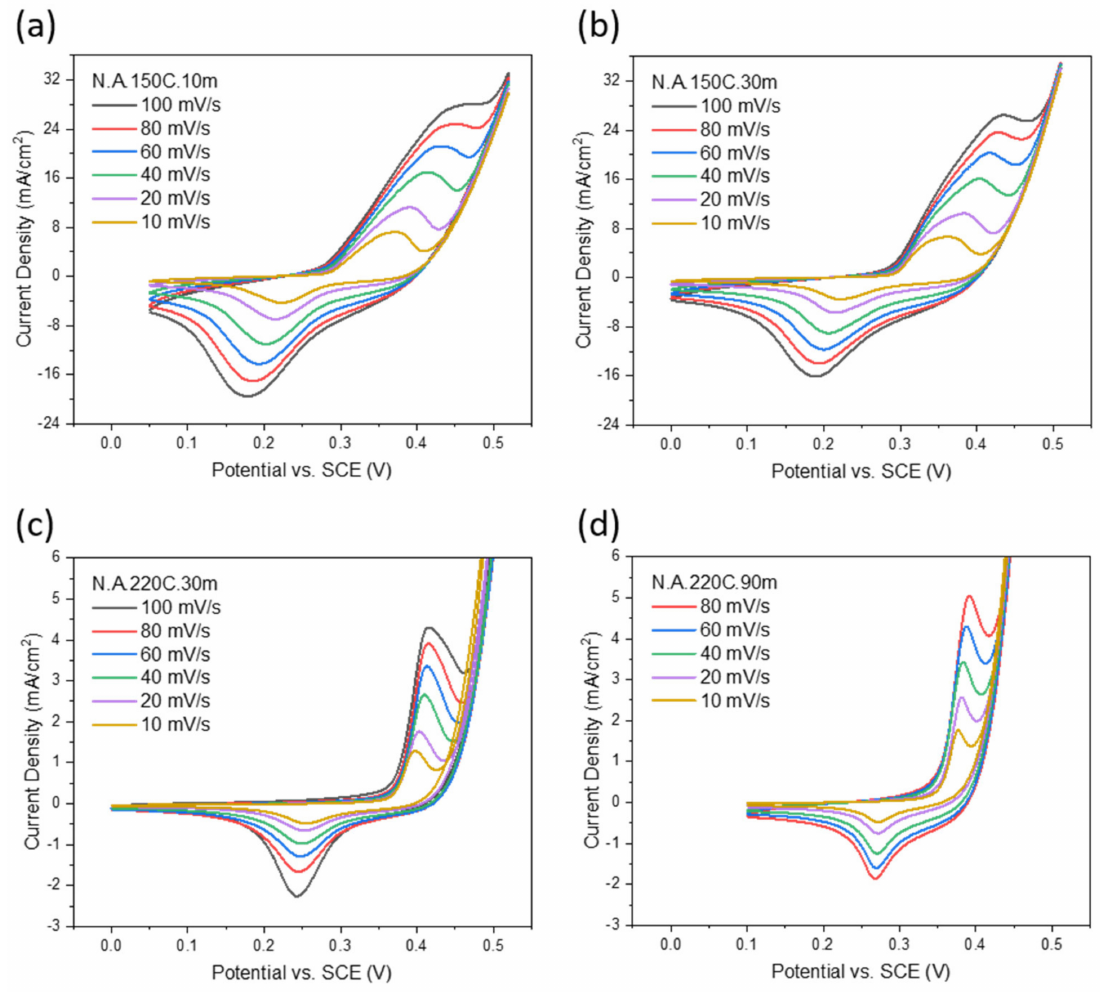
Figure 4. CV curves of ( a ) N.A.150C.10m, ( b ) N.A.150C.30m, ( c ) N.A.220C.30m, and ( d ) N.A.220C.90m electrodes on SS at different scan rates in KOH